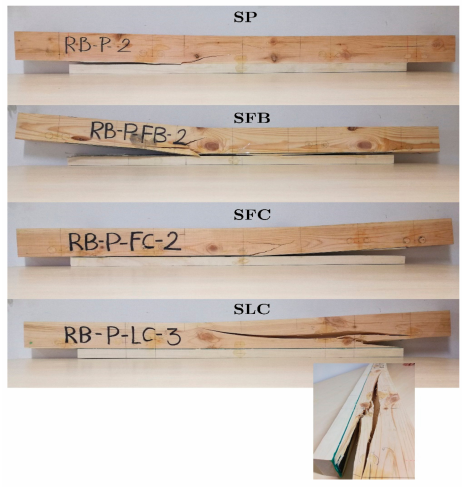
Figure 8. Fracture pattern of the specimens.